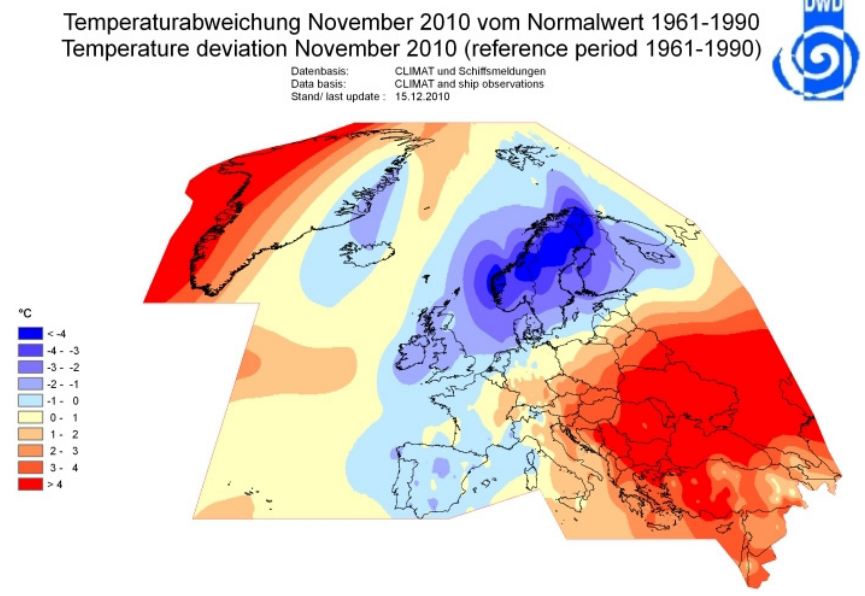
Figure 1. Example map of monthly temperature anomaly in November 2010 (Source: Deutscher